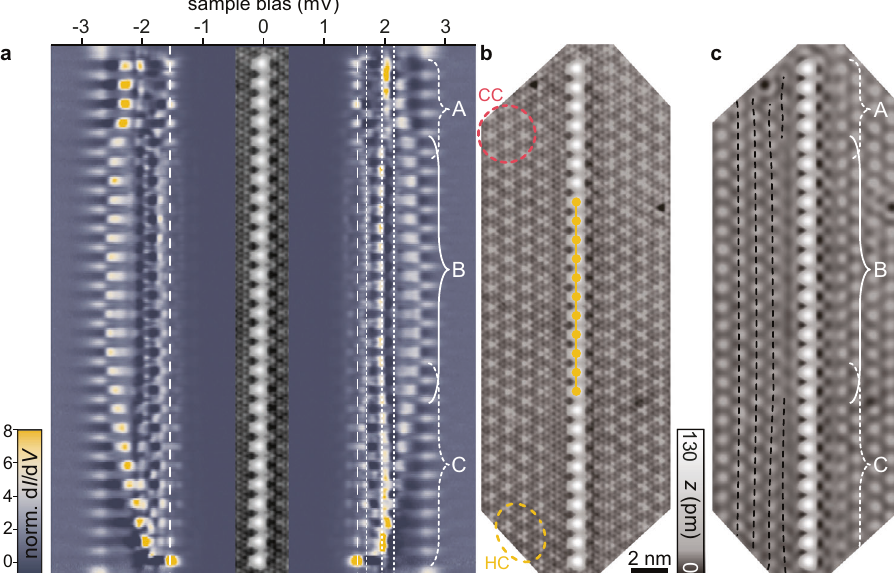
Fig. 5 Band banding in longer Fe chains. a Stacked constant-height d I /d V spectra (normalized) recorded along a line across the 27-atom chain as illustrated in the inset topography. Set point for the spectra is 700 pA, 5 mV with a modulation of 15 μ V. The (Nb) tip gap Δ tip ≈ 1.55 meV is indicated by white dashed lines. White dotted lines are at the same energies as in Fig. 4 and indicate the van Hove singularities of the α - and β -derived bands. b Larger range STM topography of the 27-atom chain. The position of the former 11-atom chain (Fig. 4h) is indicated in yellow (constant-current set point is 100 pA, 10 mV). A hollow-centered (HC) region of the CDW is highlighted by a yellow circle, a Se-centered (CC) region is marked in red. c A FFT- fi lter has been applied to the STM topography in b to remove the atomic corrugation. Dashed lines on the left of the chain serve as guide to the eye to illustrate the CDW order in the vicinity of the chain. Different sections of the chain are labeled with A –